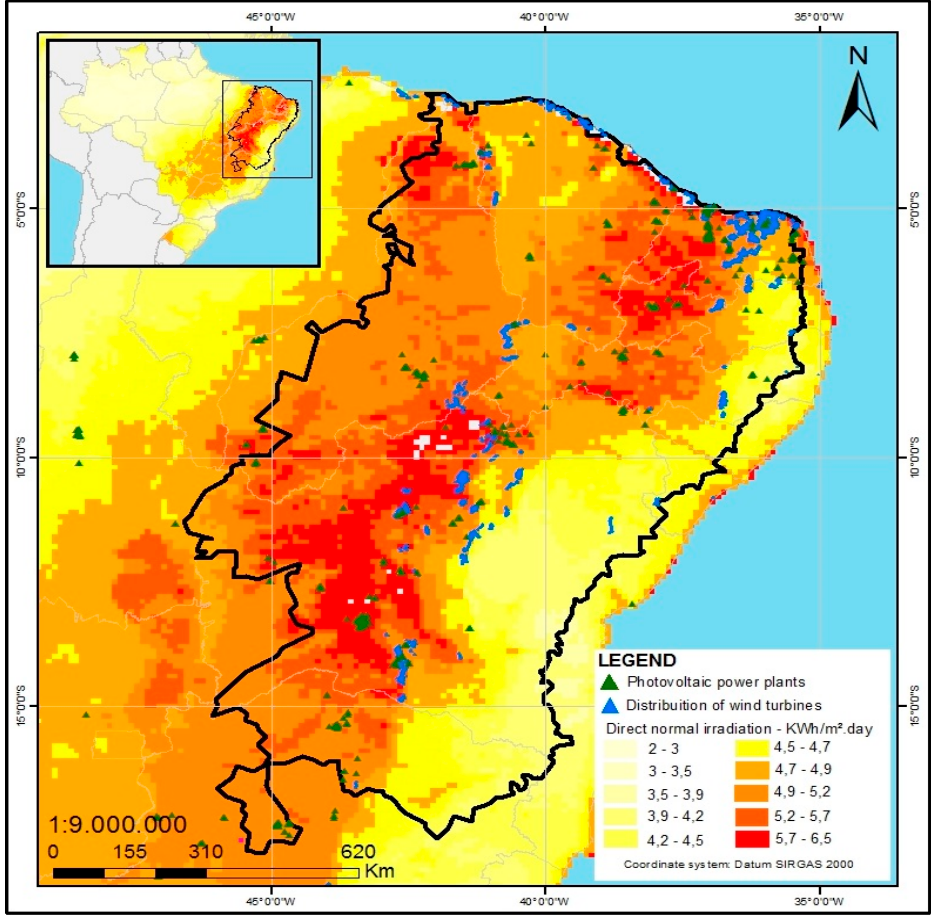
Figure 1. Normal direct solar irradiation and distribution of photovoltaic plants and wind farms in the Brazilian semi-arid region. Source: The Datum Sirgas 2000 coordinate system, with data sourced from [35–38].